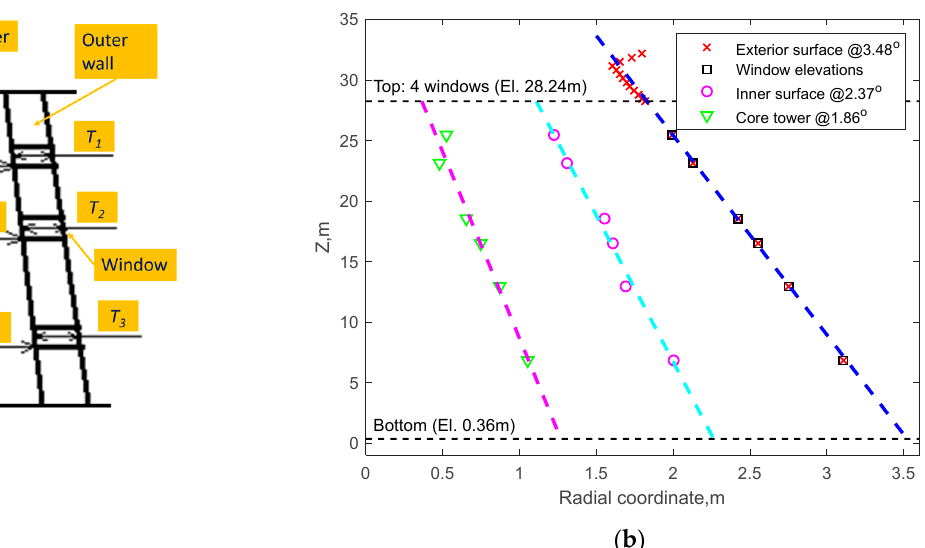
Figure 12. Measurements at window elevations: core tower and wall thickness: ( a ) schematic; ( b ) measured core tower and wall thickness.